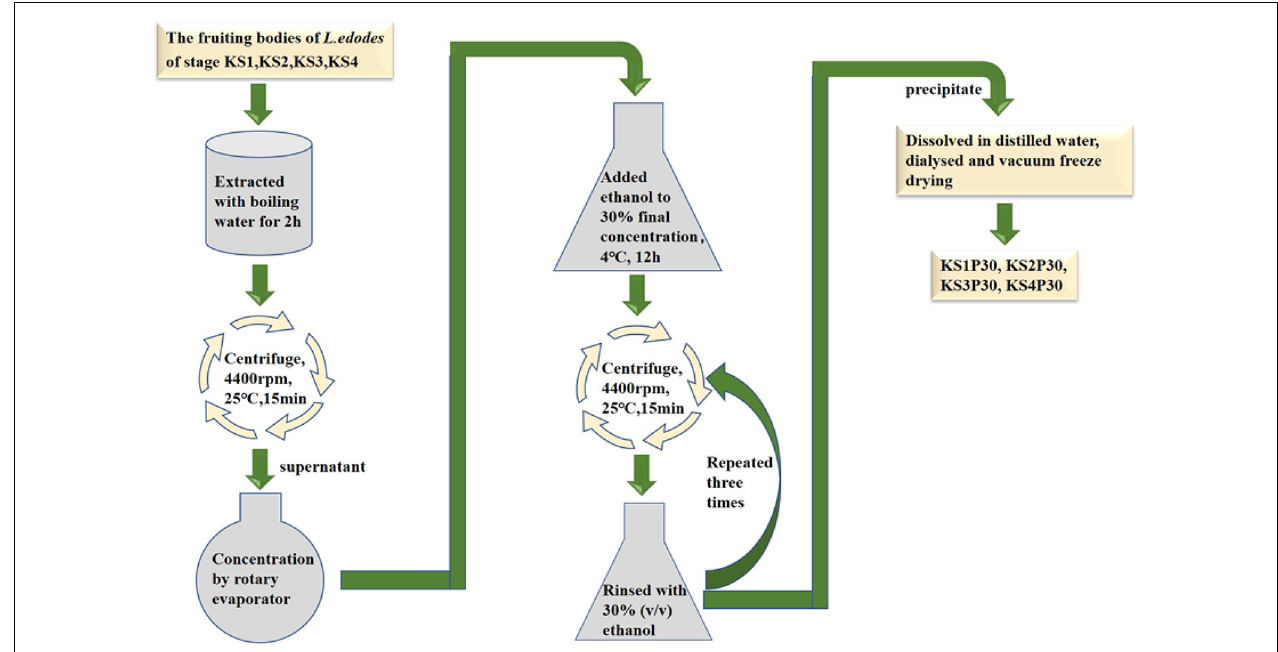
FIGURE 2 | Preparation process of KS1P30, KS2P30, KS3P30, and